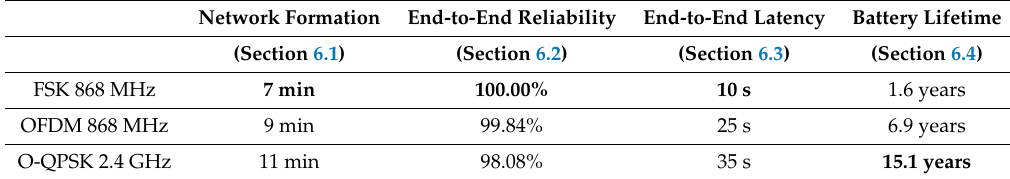
Table 5. Summary of the Key Performance Indicator (KPI) measured in our testing. The best values are shown in